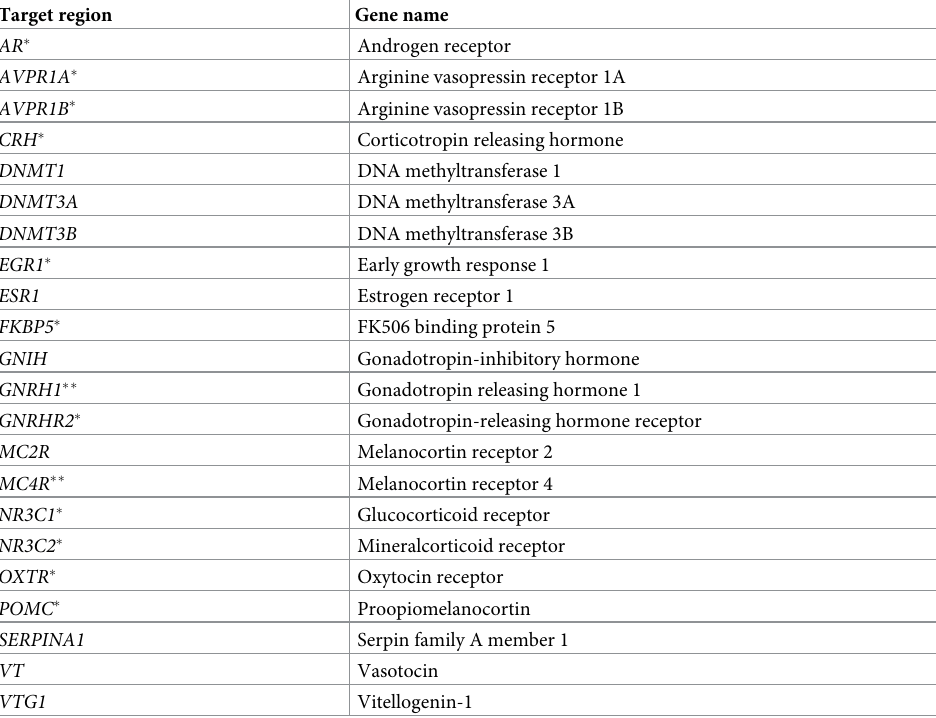
Table 1. Targeted genomic regions for superb starling baits. Although we targeted putative promoter regions of all of the genes (i.e., 4 kb upstream of the transcription start site where annotated), we also targeted complete exonic regions (indicated by � ) or gene body regions (based on similarity with Ensembl genome sequences, including the col- lared flycatcher for GNRH1 and zebra finch for MC4R , indicated by �� ) in a subset of the genes. Target